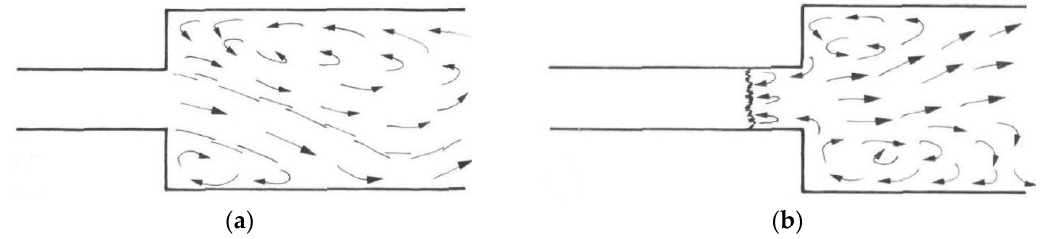
Figure 1. Schematic sketch of streamlines for ( a ) S-jump and ( b ) T-jump [29].